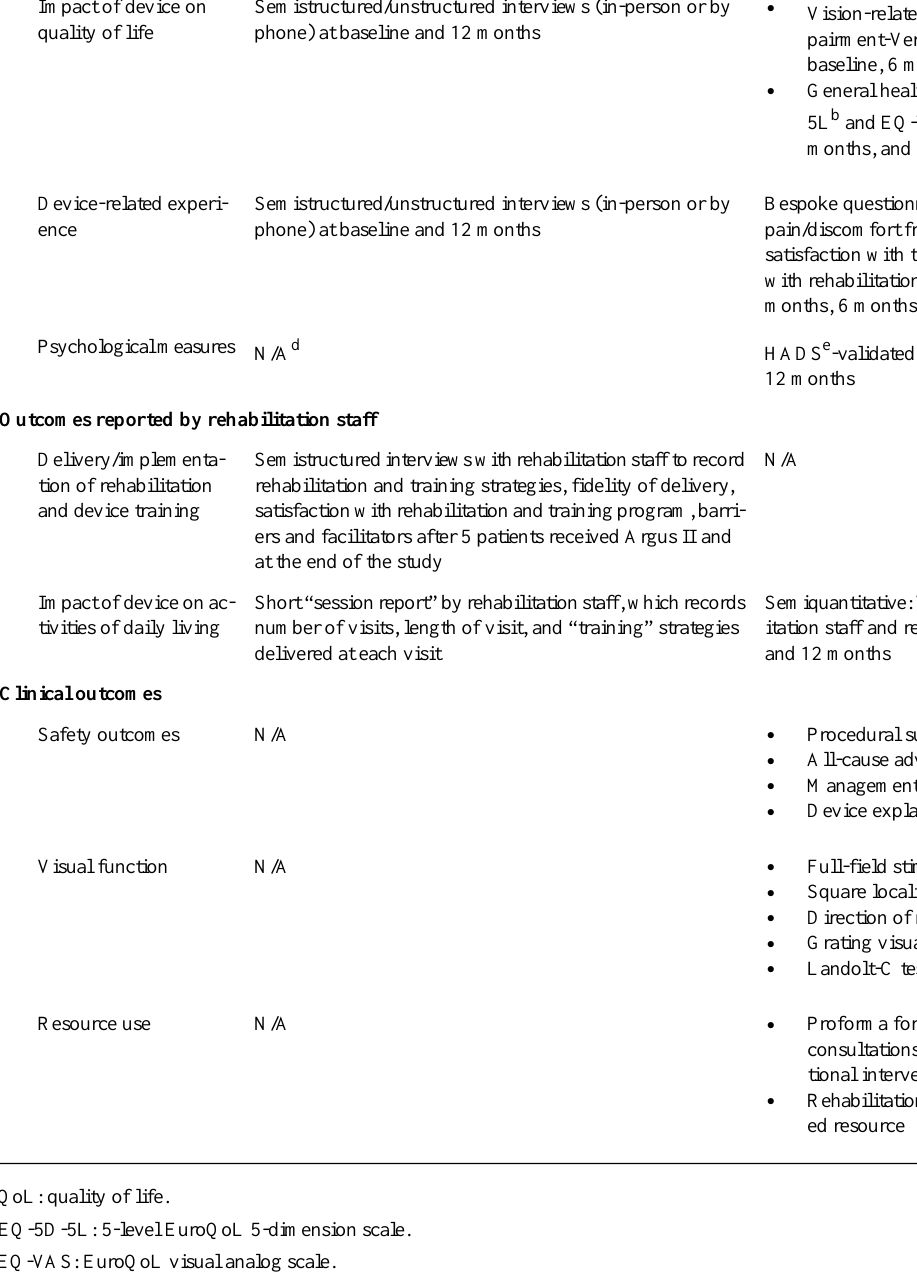
Table 2. Qualitative and quantitative outcome measures. Participant-reported